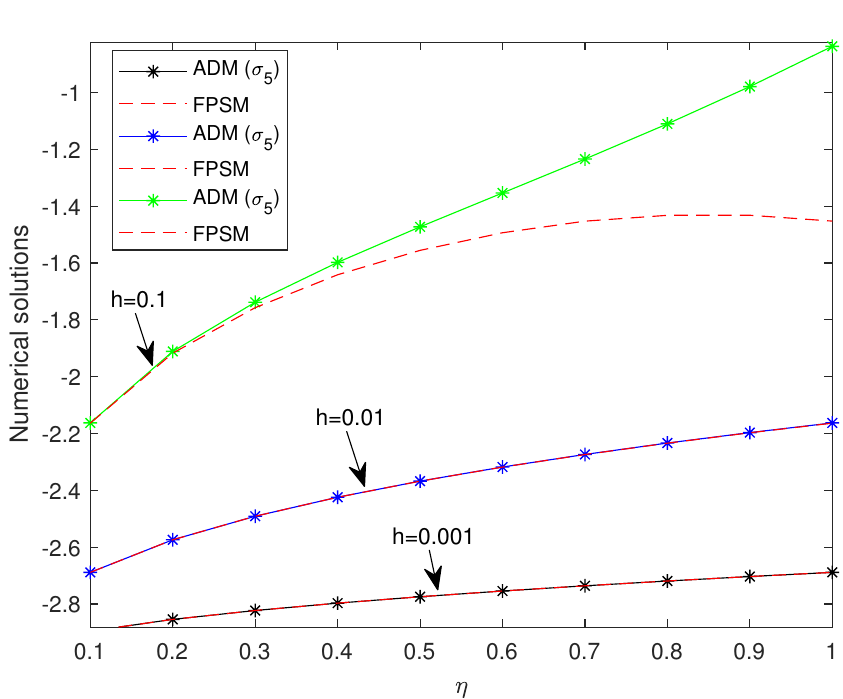
Figure 1. The ADM ( σ 5 ) and FPSM solutions of Equation (32), Υ ( η ) vs η , for h = { 0.1,0.01,0.001 }